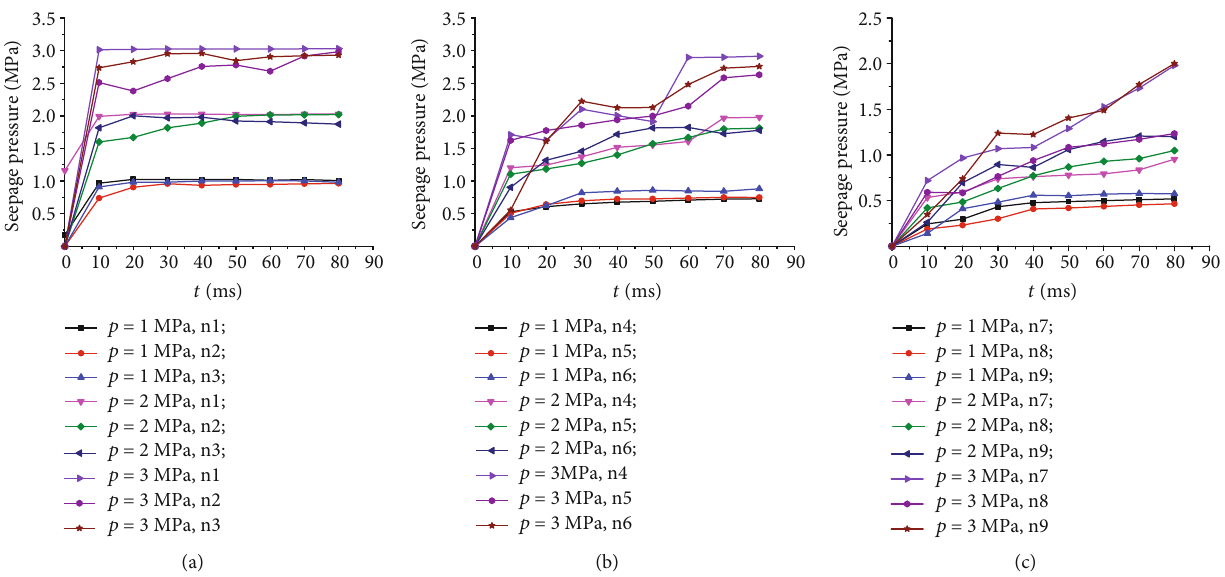
Figure 4: The trend of seepage pressure at the 9 measuring points in the conditions of p = 1 , 2, and 3MPa: (a) n1 ~ n3 on HL1; (b) n4 ~ n6 on HL2; (c) n7 ~ n9 on